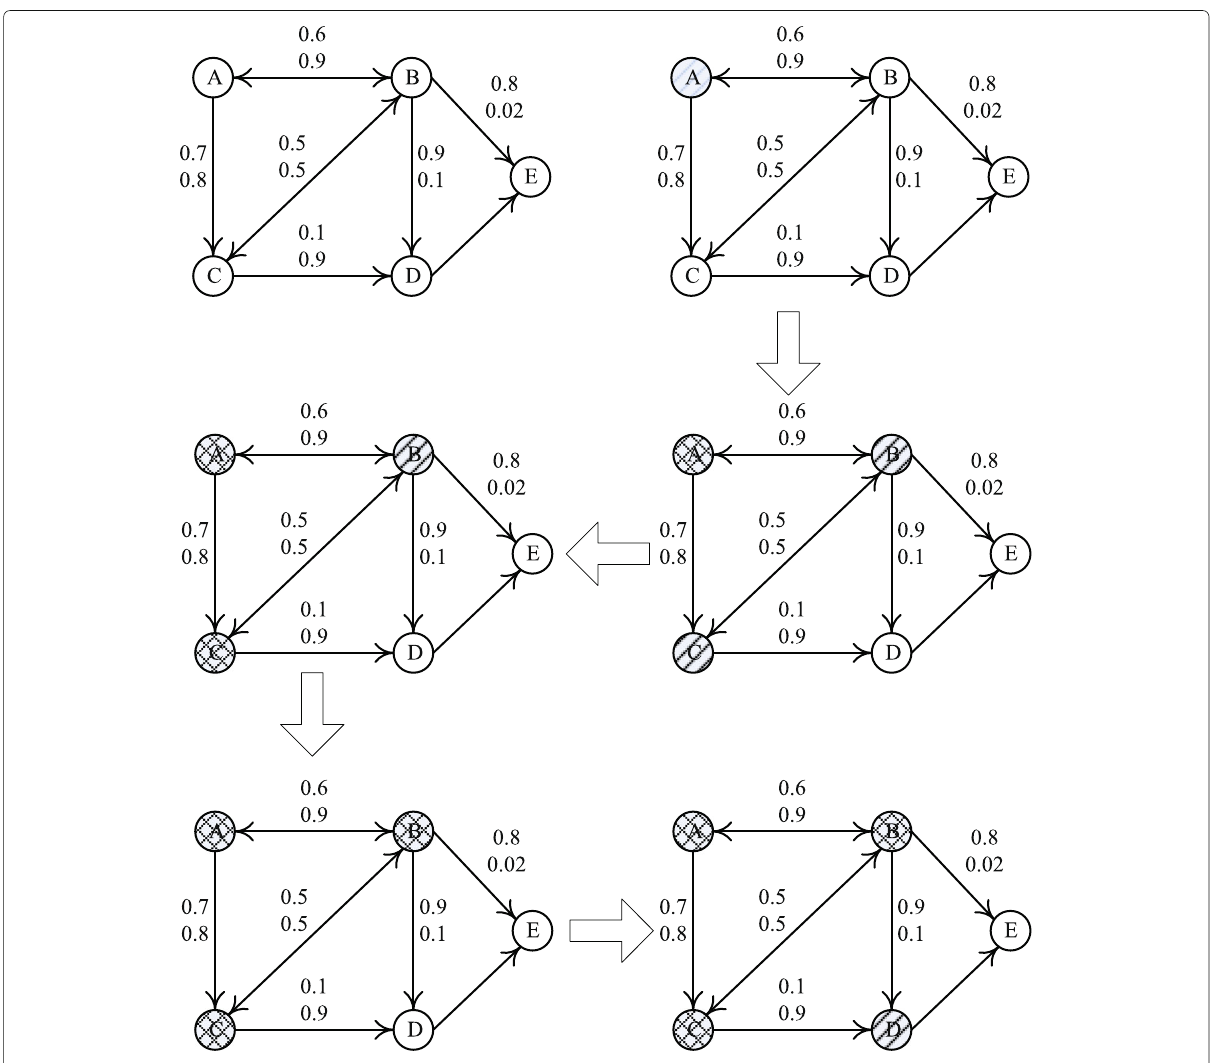
Fig. 1 An example of IDC model and the procedure of information diffusion in IDC model